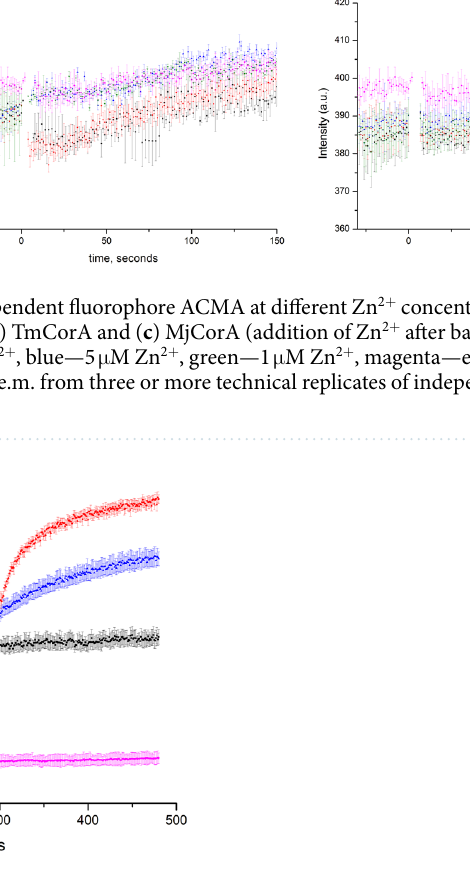
Figure 6. Effect of membrane potential on the transport of Zn 2 + (added after 1 min) assayed by the fluorophore FluoZin-1 trapped inside the proteoliposomes with EcZntB (black), TmCorA (red) and MjcorA (blue) and empty liposomes (magenta). 1 μ M of valinomycin were added after 5 min. Error bars represent s.e.m. from three or more technical replicates of independent batches of proteoliposomes.